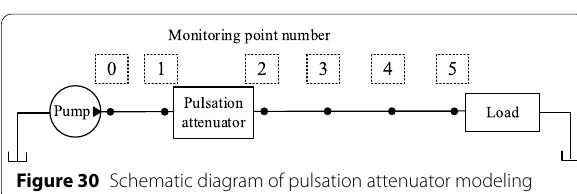
Figure 30 Schematic diagram of pulsation attenuator